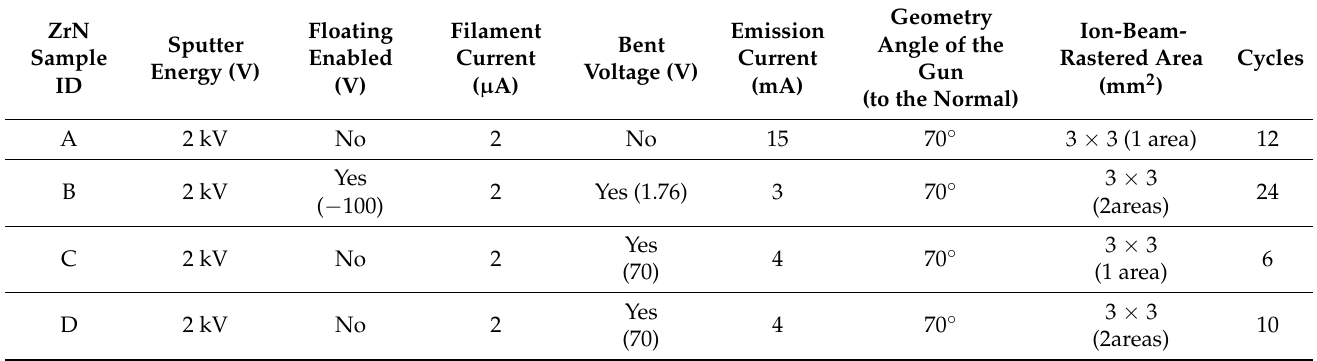
Table 3. Sputtering parameters of the Ar+ ion gun related to an average pressure of 1.8 × 10 − 6 mbar in the main chamber during gentle erosion (group